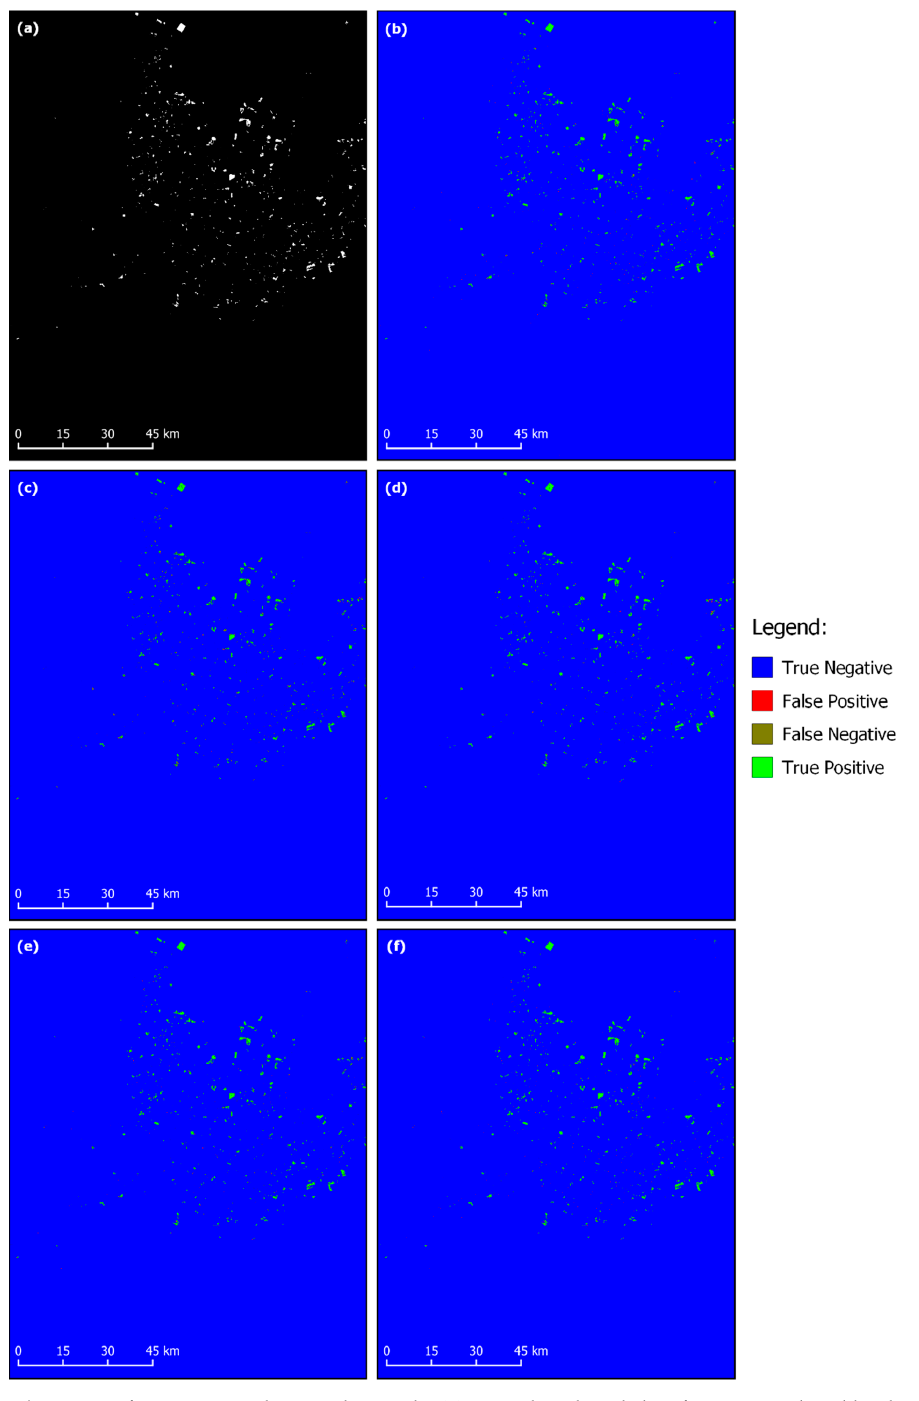
Figure 7. Deforestation masks according to the ( a ) ground truth and classifications produced by the ( b ) random forest (RF), ( c ) multilayer perceptron (MLP), ( d ) SharpMask, ( e ) U-Net, and ( f ) ResUnet models in the 2017–2018 sequence.